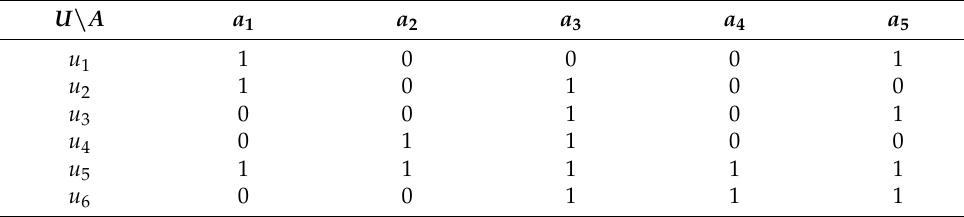
Table 1. A transactional database A = ( U , A ) .